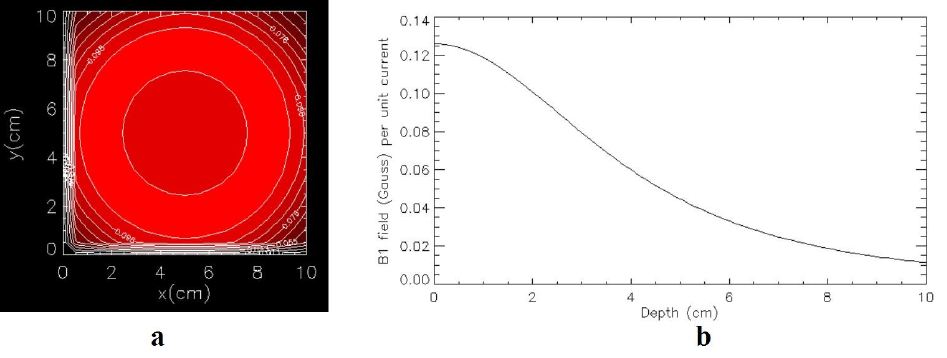
Figure 1. A 5 cm radius circular coil magnetostatic simulation: ( a ) the normalized magnetic field as a contour plot at z = 2 cm and ( b ) the normalized magnetic field in the z-axis vs. the depth profile.